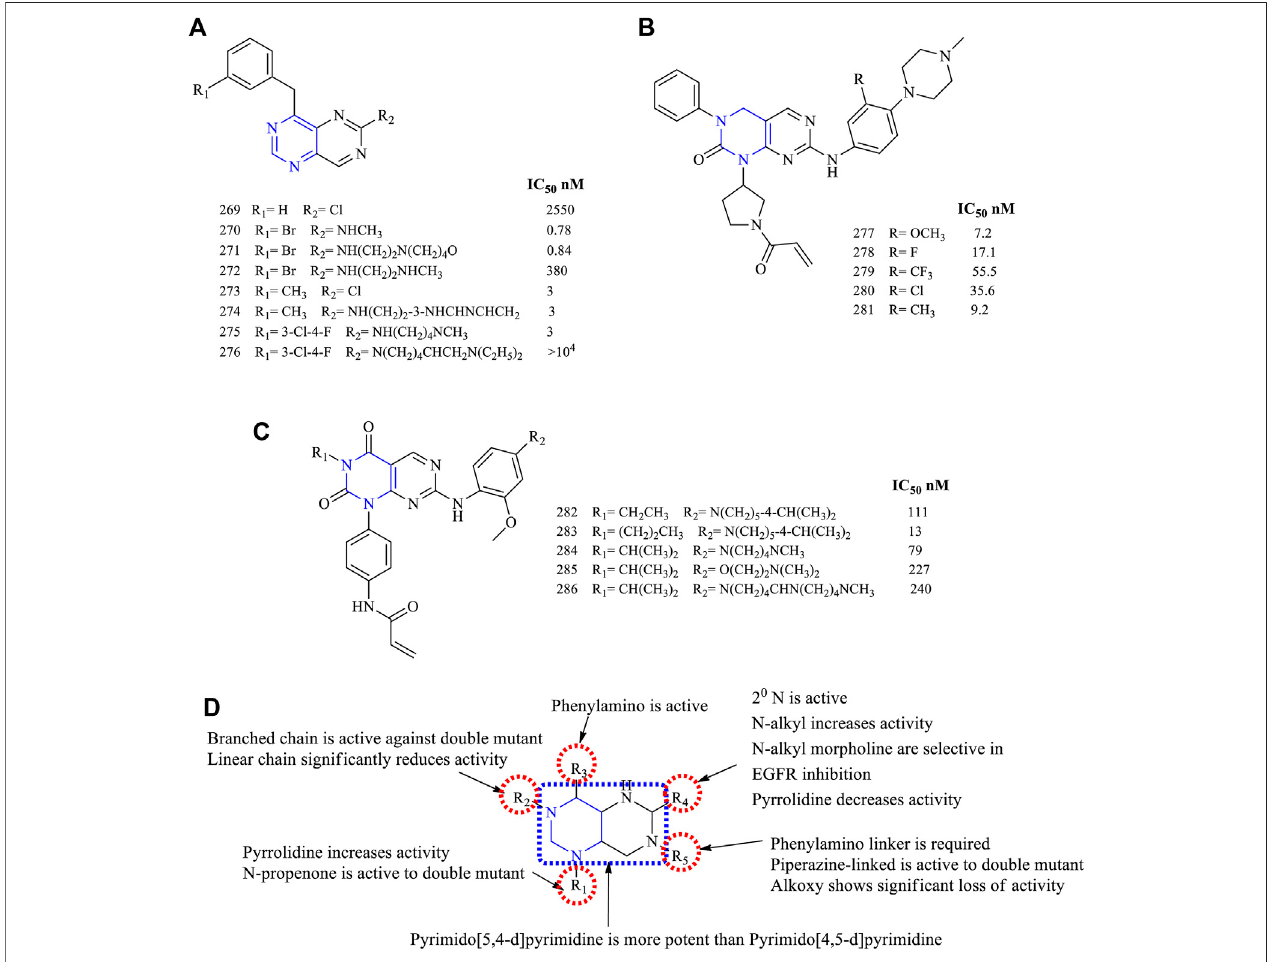
FIGURE 19 | Chemical structure of (A) 4-amino-6-substituted pyrimido[5,4- d ]pyrimidine, (B) 2-oxo-3,4-dihydropyrimido[4,5- d ]pyrimidine, (C) pyrimido[4,5- d ] pyrimidin-2,4-(1H,3H)-dione, and (D) summary SAR of pyrimido[5,4- d ]pyrimidine.